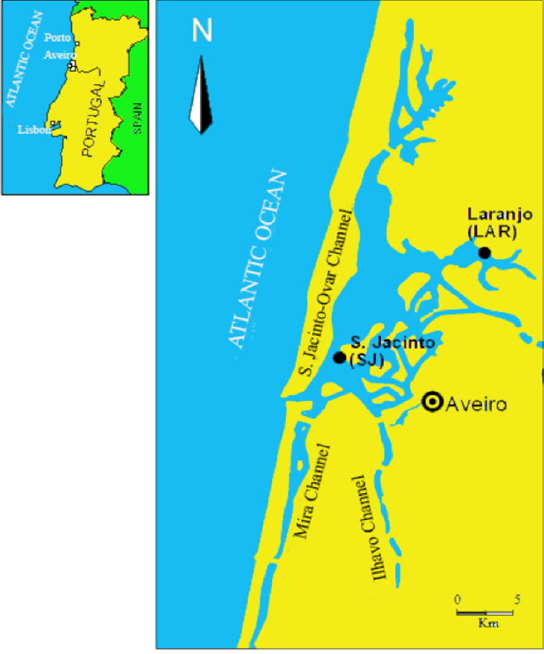
Figure 1. Location of the fish sampling sites at Aveiro lagoon (Portugal): São Jacinto (SJ) (40°41 ′ 00 ′′ N, 8°42 ′ 44 ′′ W) and Laranjo (LAR) (40°43 ′ 28.98 ′′ N, 8°37 ′ 35.80 ′′ W).